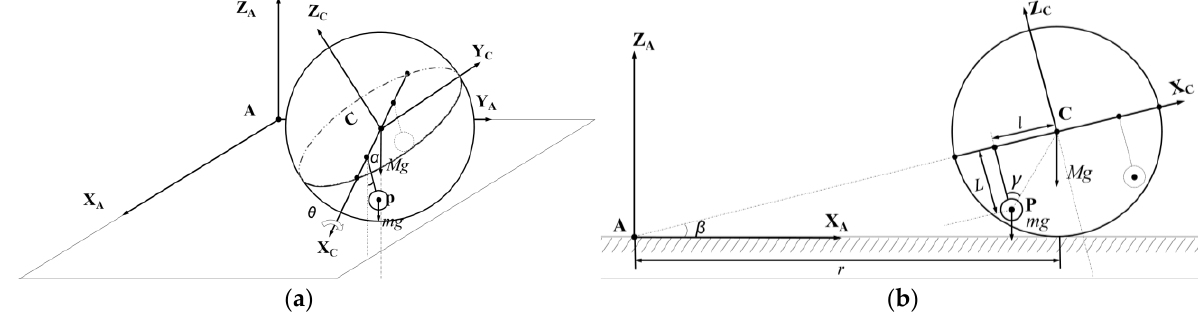
Figure 12. ( a ) Schematic diagram of steering movement; ( b ) View of X C Z C -plane of the schematic diagram of steering movement.